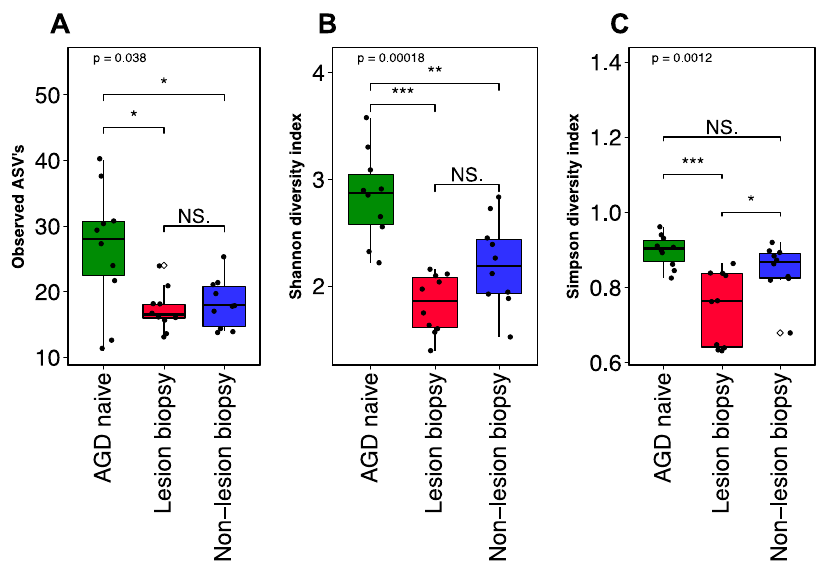
Figure 3. Measures of bacterial alpha diversity in naïve and AGD affected salmon gill. Mean species richness ( A ) was higher in naïve smolt than both AGD groups, whilst diversity ( B and C ) were highest in Naïve fish, and significantly different between Naive and LB AGD groups. Black dots represent each individual sample point, unfilled diamond shape indicates outliers. P = global significance (Kruskall Wallis), pairwise significance determined by a Wilcoxon test with p < 0.05, p < 0.01 and p < 0.001 represented by *, **, and ***. Comparison of between-sample variance of bacterial communities by group was investigated by non-metric multidimensional scaling plots using ranked distance metrics (Figure 4A). Statistical analysis of similarity (ANOSIM) between lesion biopsy groups, demonstrated a significant difference between bacterial community composition of naïve, LB and NLB groups (ANOSIM, p < 0.05). Between AGD sample comparison (Figure 4B) indicates some overlap and variation between the LB and NLB groups, where there was appreciable interspecific (fish-to-fish) variation. (Figure 4B).